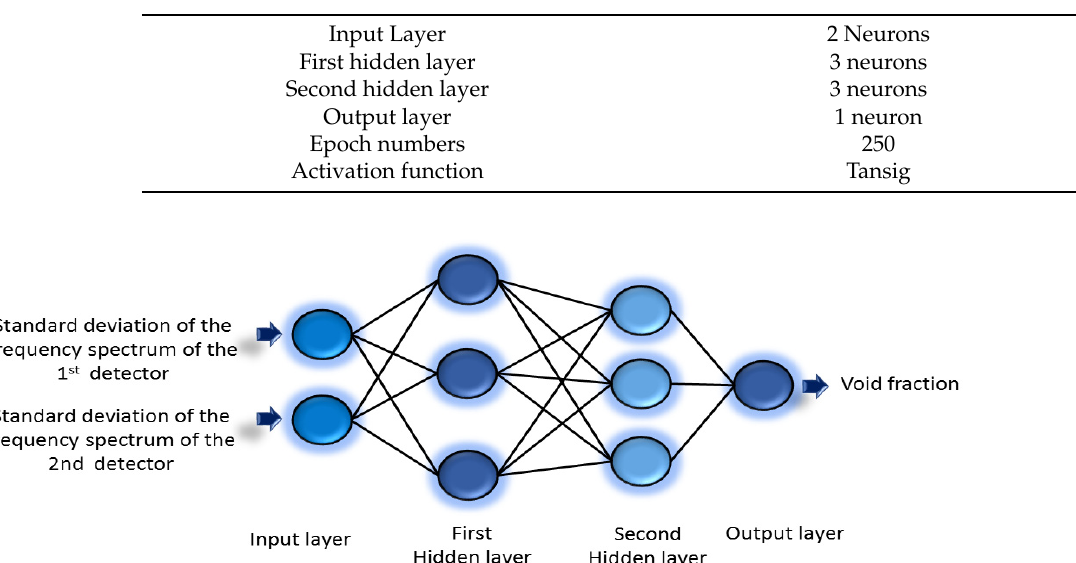
Table 2. The neural network parameters utilized for void fraction measurement.